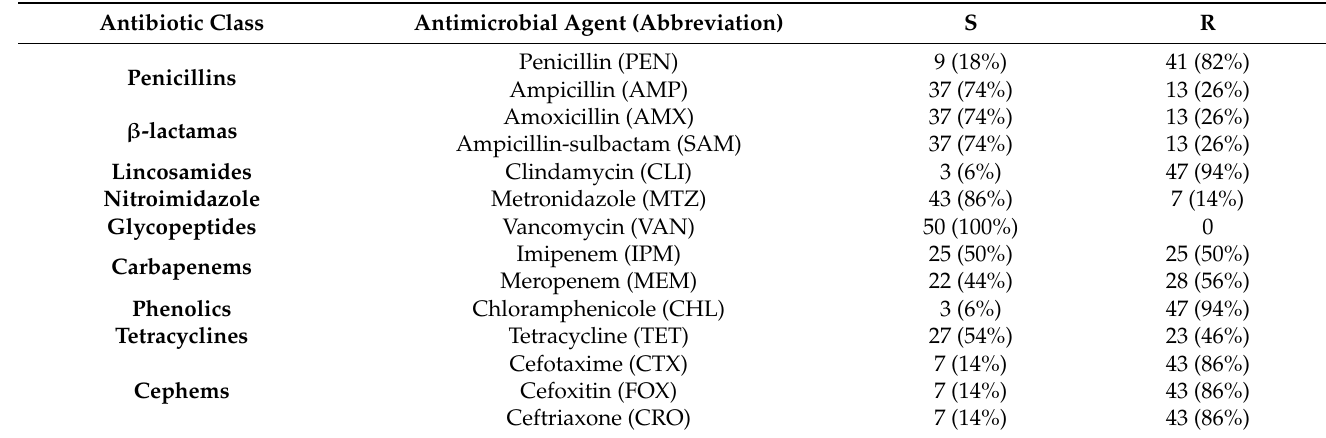
Table 2. Antibiotic susceptibility of 50 Clostridium perfringens isolates from chicken, pigeons, camels, and human sources.